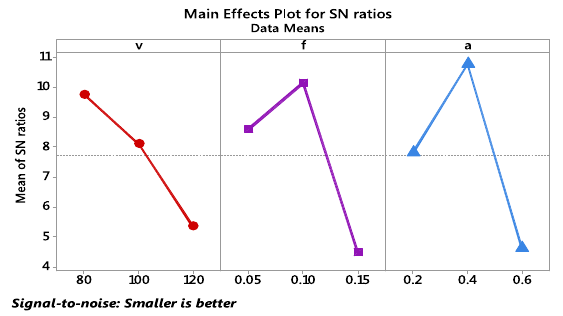
Fig. 2 Mean of S/N ratio for Ra